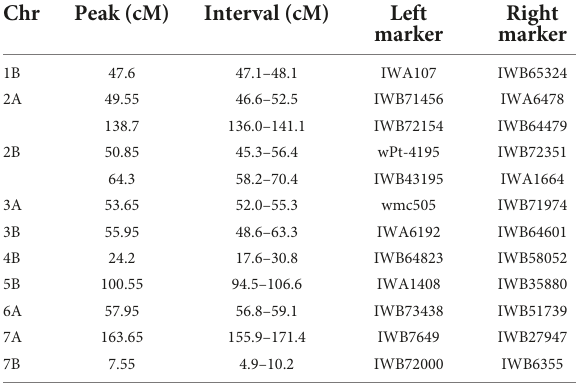
TABLE 5 Regions of the genome where MQTL identified under both water regimes overlap.